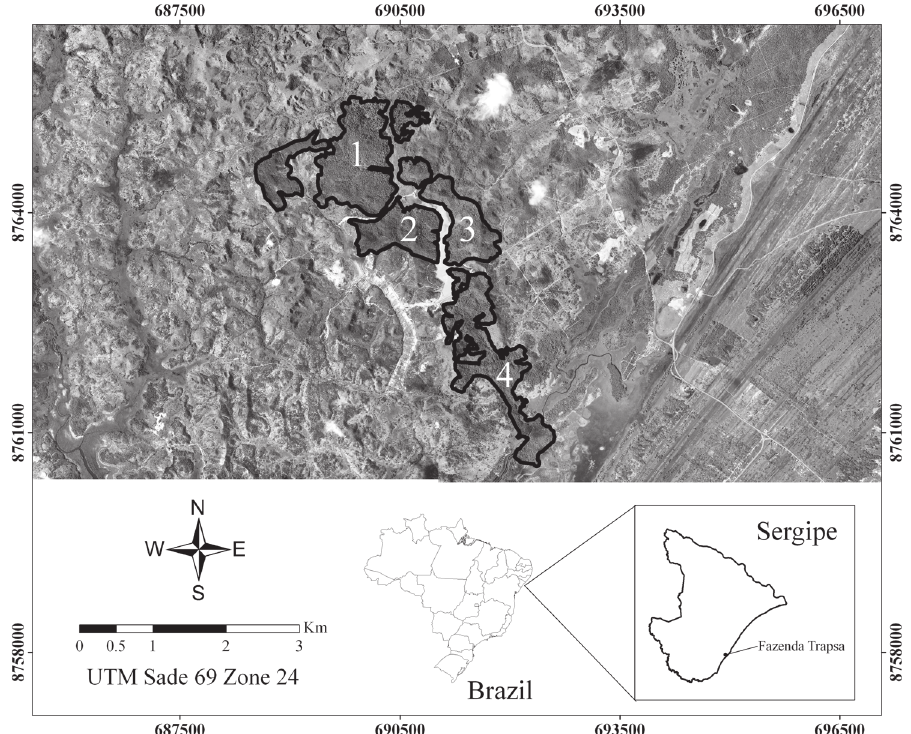
Figure 1. Aerial photograph of the Fazenda Trapsa, Sergipe, showing the four fragments surveyed in the present study (numbered – see table II). The striated area in the east is the coastal